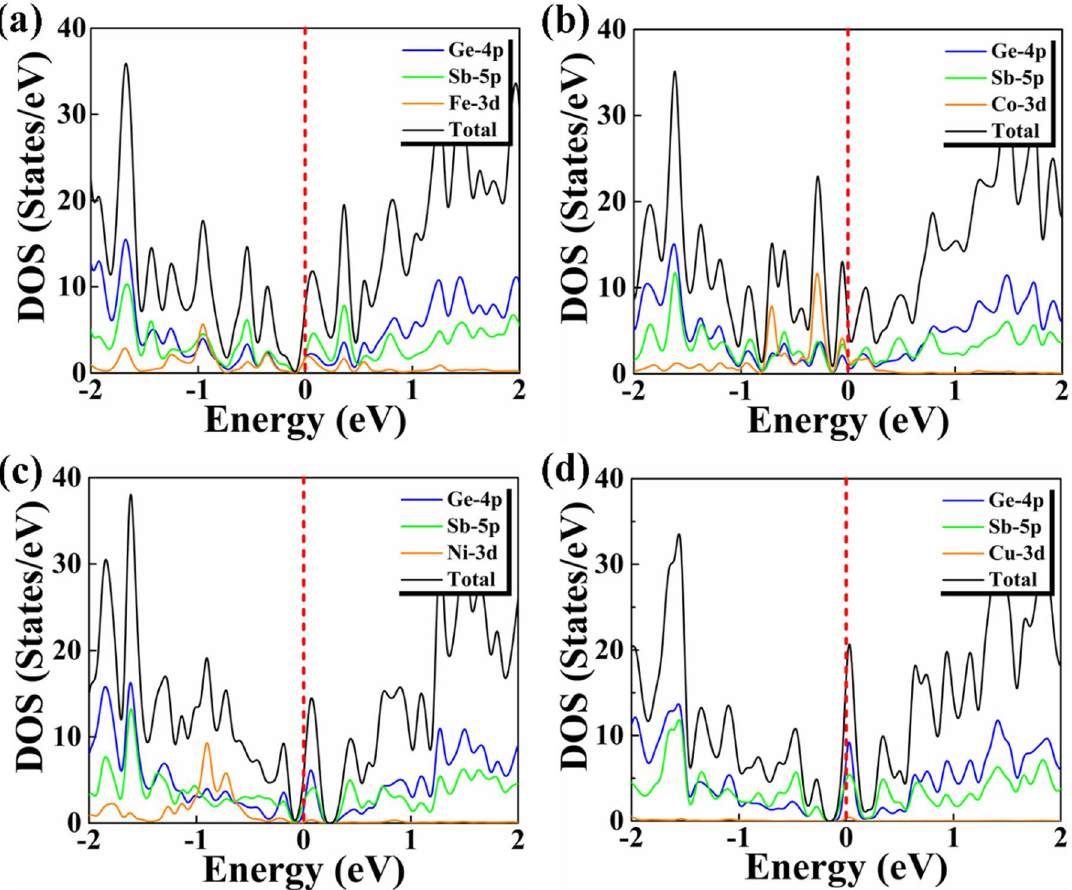
Figure 8. The partial density of states graph of ( a ) Fe, ( b ) Co, ( c ) Ni and ( d ) Cu doped Sb/Ge NW with the Sb